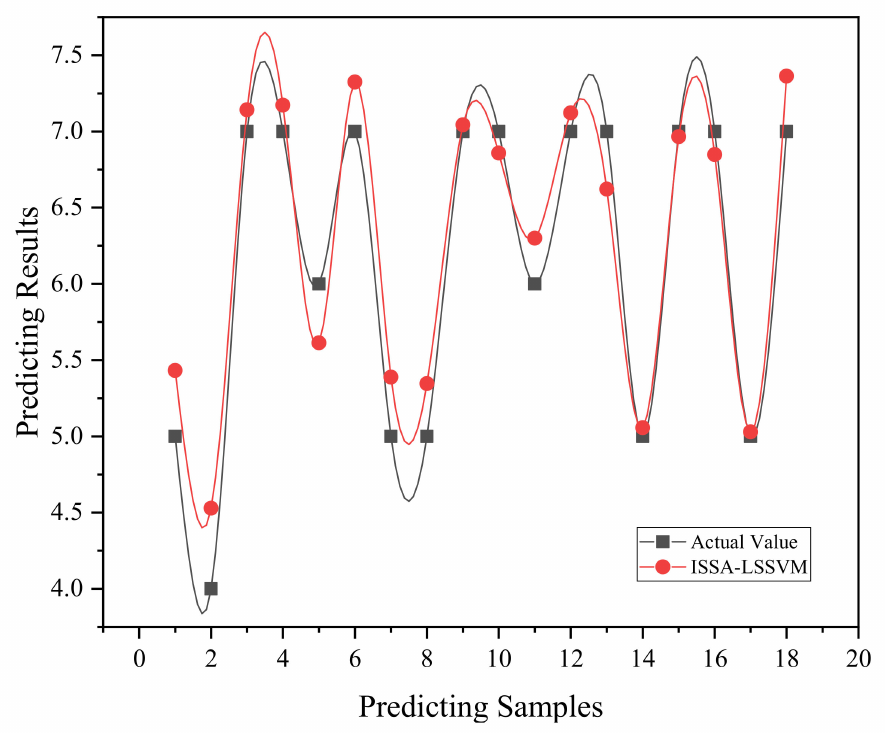
Figure 3. ISSA-LSSVM model prediction results.